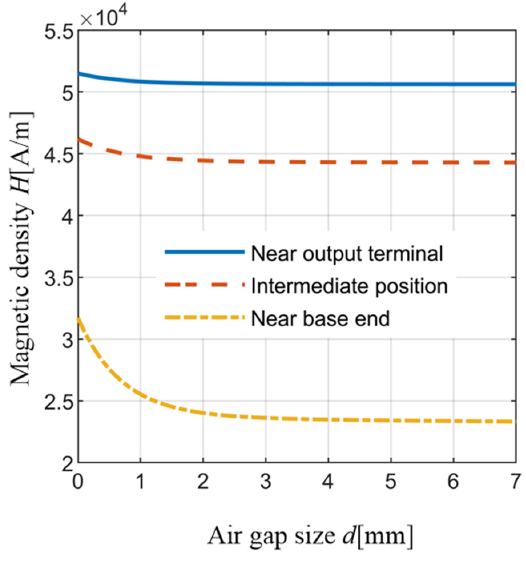
Figure 17. Change in magnetic density on GMM cylinder with changing air gap size.